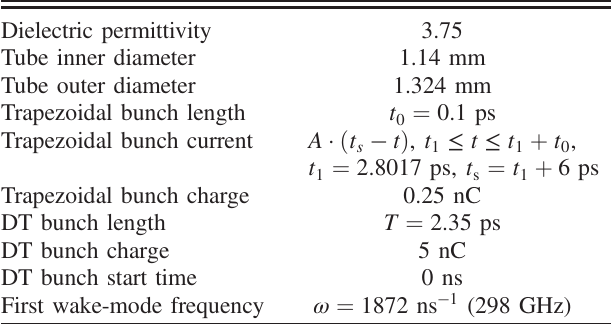
TABLE I. The parameters for the dielectric tube and electron bunches for a DWA at 300 GHz.